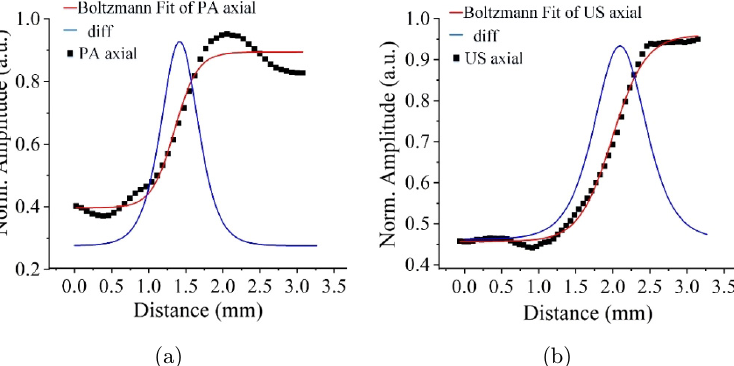
Fig. 7. (a) B-scanned PA signal amplitudes and the axial resolutions of the PA imaging system. (b) B-scanned US signal amplitudes and the axial resolutions of the US imaging system.